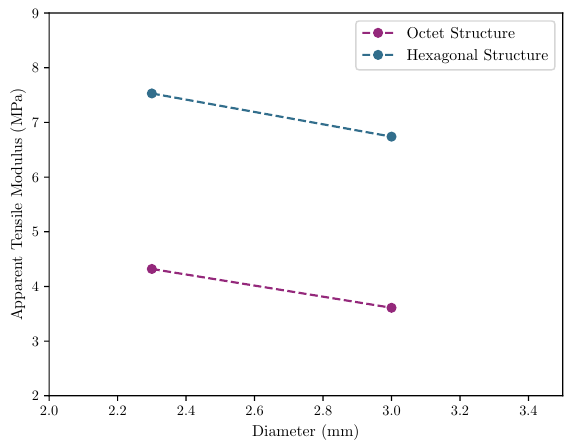
Figure 11. Influence of the Diameter on the Apparent Tensile